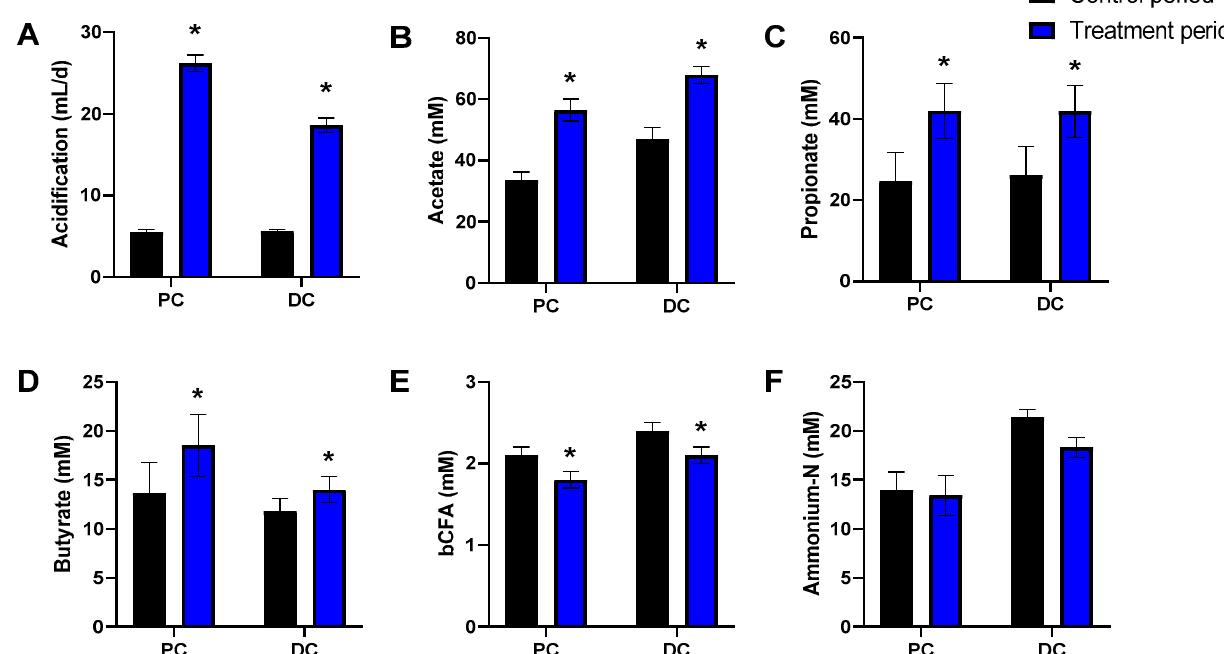
Figure 4. Effect of fermentation of cRG-I on microbial activity in the simulated proximal and distal colon of the quad-M- SHIME during both the control (Days 9–14) and treatment period (Days 30–35). Average (±SEM) acidification (base-acid consumption in mL/d; ( A ), acetate ( B ), propionate ( C ), butyrate ( D ), bCFA ( E ), and ammonium-N levels ( F ) across four human adult donors tested ( n = 4). Statistically significant differences between samples collected during the final control and treatment week are indicated by * ( p < 0.05). bCFA = branched-chain fatty acids, cRG-I = carrot-derived Rhamnogalacturonan I, DC = distal colon, PC = proximal colon.